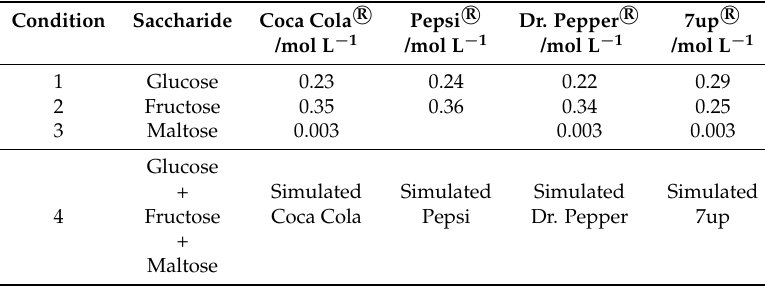
Table 1. Half-cell conditions for soft drinks electro-oxidation on PtRu/C.